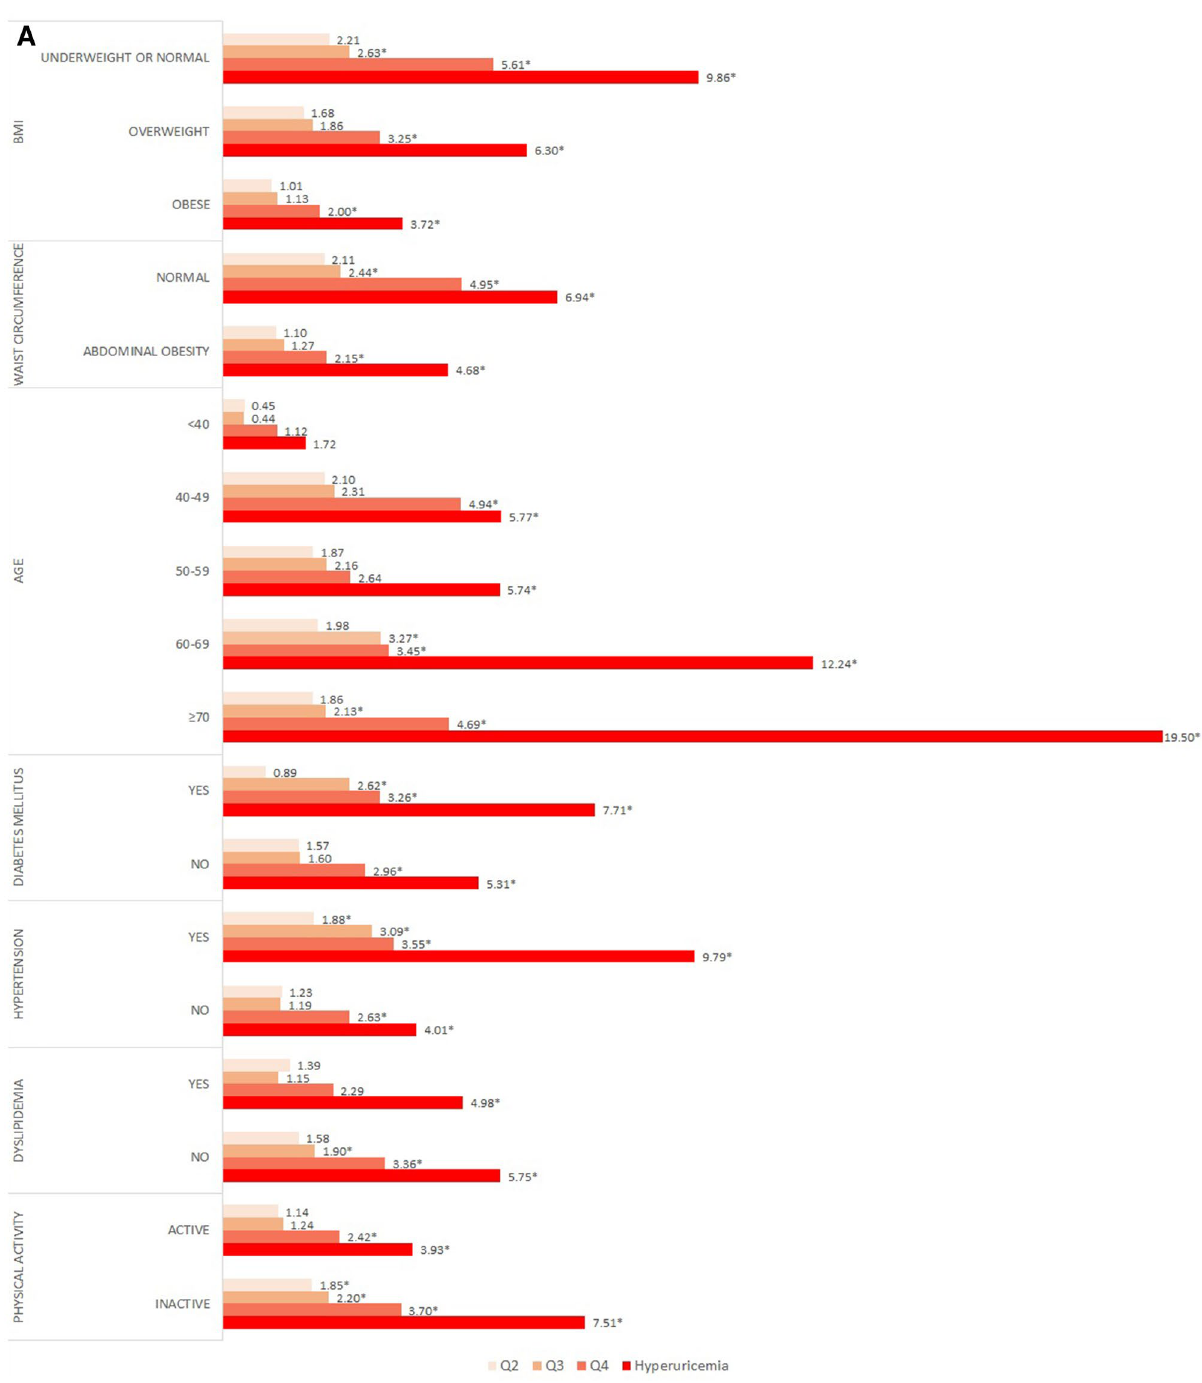
Figure 1. Subgroup analysis presenting odds ratio for decreased kidney function stratified by covariates in ( A ) men, ( B ) women. † Analysis was adjusted for all sociodemographic, economic, health-related factors considered in the study. ‡ * indicate statistically significant results ( P <